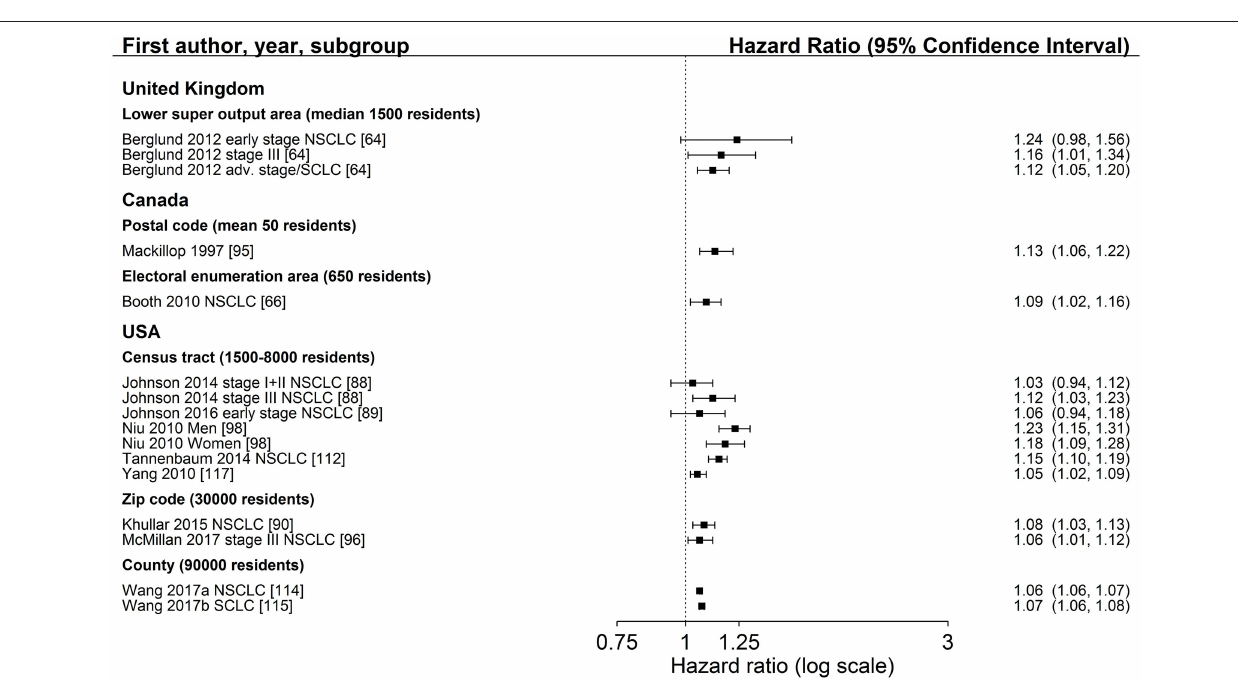
code and county (zip code: HR 1.08, 95 % CI 1.03–1.13;